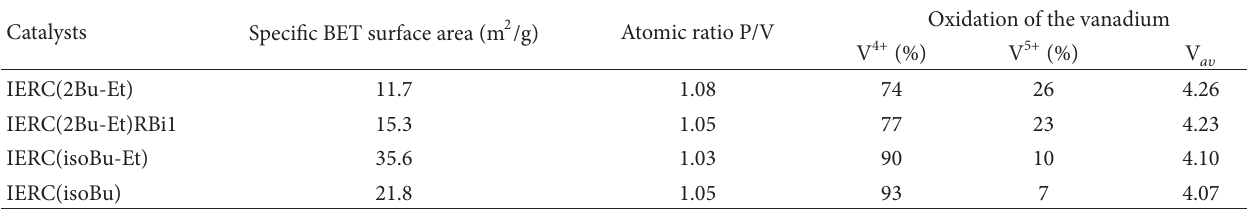
T 1: �peci�c BET surface area, chemical properties, average vanadium valence, and percentages of V